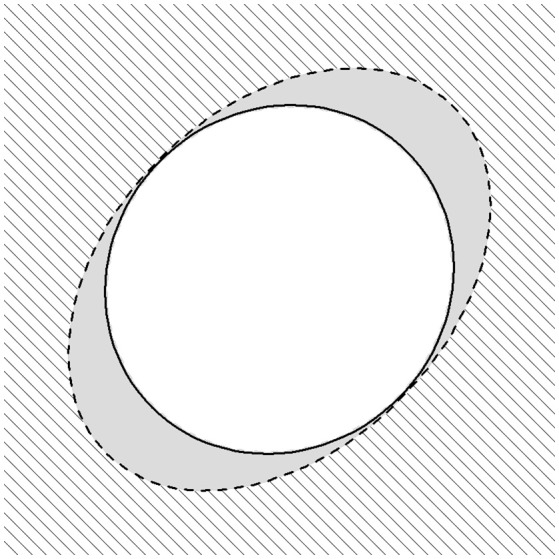
The composite rejection region of POPFAM+. The area outside the black dashed ellipse defines the rejection region of a χ2 test with 2 degrees of freedom with size 0.1α, while the area outside the solid ellipse defines a rejection region of size α for POPFAM+. Under the null hypothesis of “no association” the two twin crescents shaded in grey each have probability 0.45α, so that the total probability across all three regions: 0.1α, 0.45α, and 0.45α sum to α.